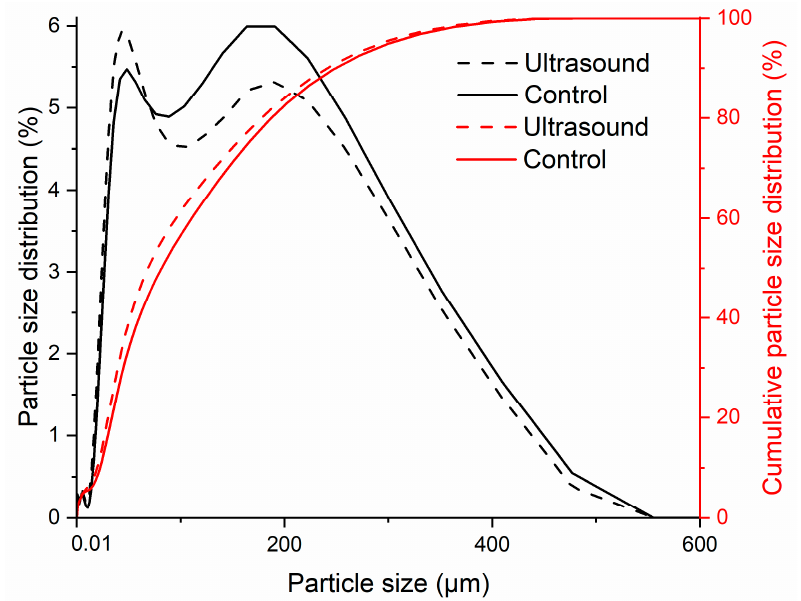
Figure 6. Particle size distribution and particle size distribution cumulative curves of control and ultrasound-extracted sago starches. ultrasound-extracted sago